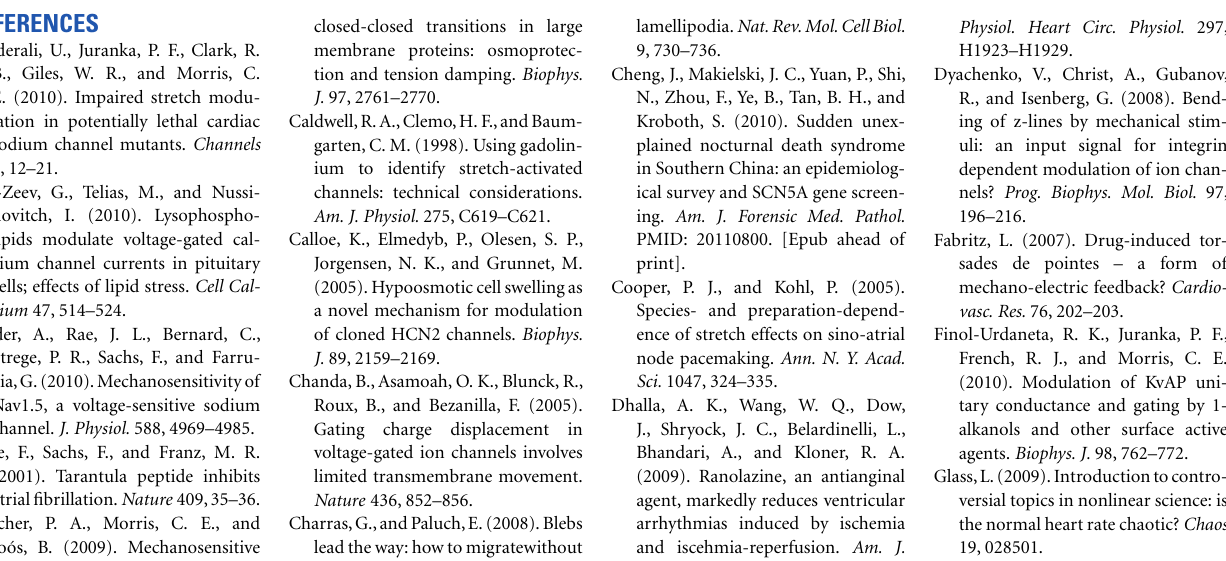
particle in its bound state (see Banderali et al., 2010). Replacing arginine (positive) at R1623 with glutamine (neutral) impairs repacking of the voltage sensor protein and reduces the voltage sensitivity ofTau inactivation. Replacing arginine at 1626 with kink-inducing proline makes the inactivation rate entirely insensitive to voltage; at all voltages, R1626P has the same low-speed inactivation.The consequence: these LQT3 Nav channels remain open too long during the action potential; excess I Na causes “torsades de pointes” arrhythmias. (B) Stretch (from pipette suction) is less effective at speeding the rate (Tau − 1 ) of I Na inactivation for R1623Q than forWT (likewise for R1626P, but not shown). (C) Overlaid stretch difference currents compare kinetics forWT and the LQT3 mutant.With increasing depolarization (imagine the action potential passing through − 30 and 0mV)WT I Na turns off (goes upward) far sooner than for R1623Q. (D) For R1626P, stretch difference current always (even at 0mV) represents excess (stretch-induced) inward I Na. The R1626P response to stretch in situ , were it to occur, would be distinctly “excitatory” and pro-arrhythmic. Figures B–D are from Banderali et al.